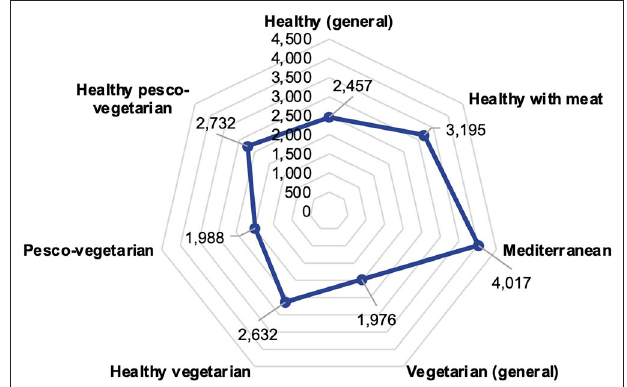
FIGURE 1 | Average green and blue water footprint (WF) of the identified healthy diets in liters per person per day (L p − 1 d − 1 ). Average healthy diet WF was 2,714L p − 1 d − 1 . Detailed information is available in Supplementary Material 3